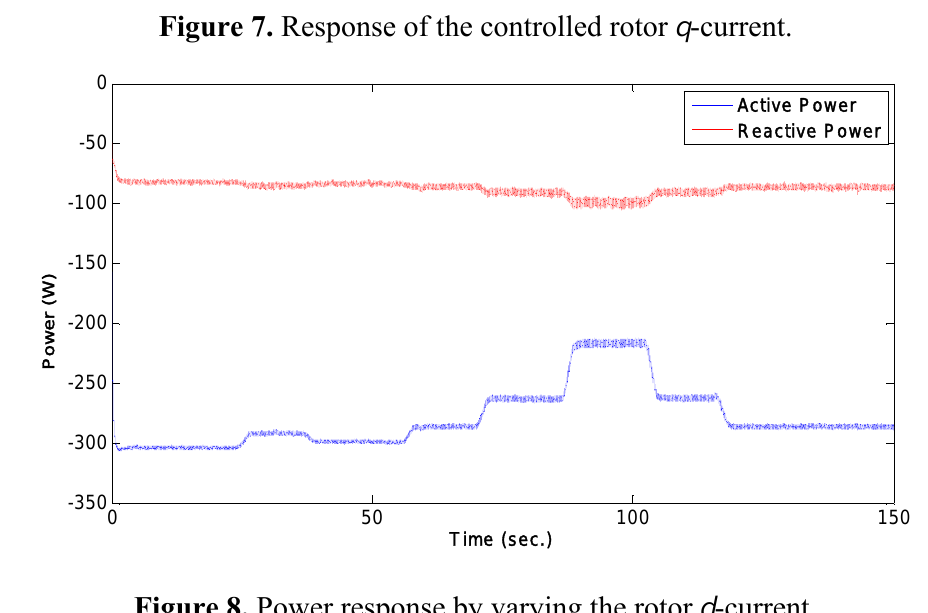
Figure 8. Power response by varying the rotor d -current.